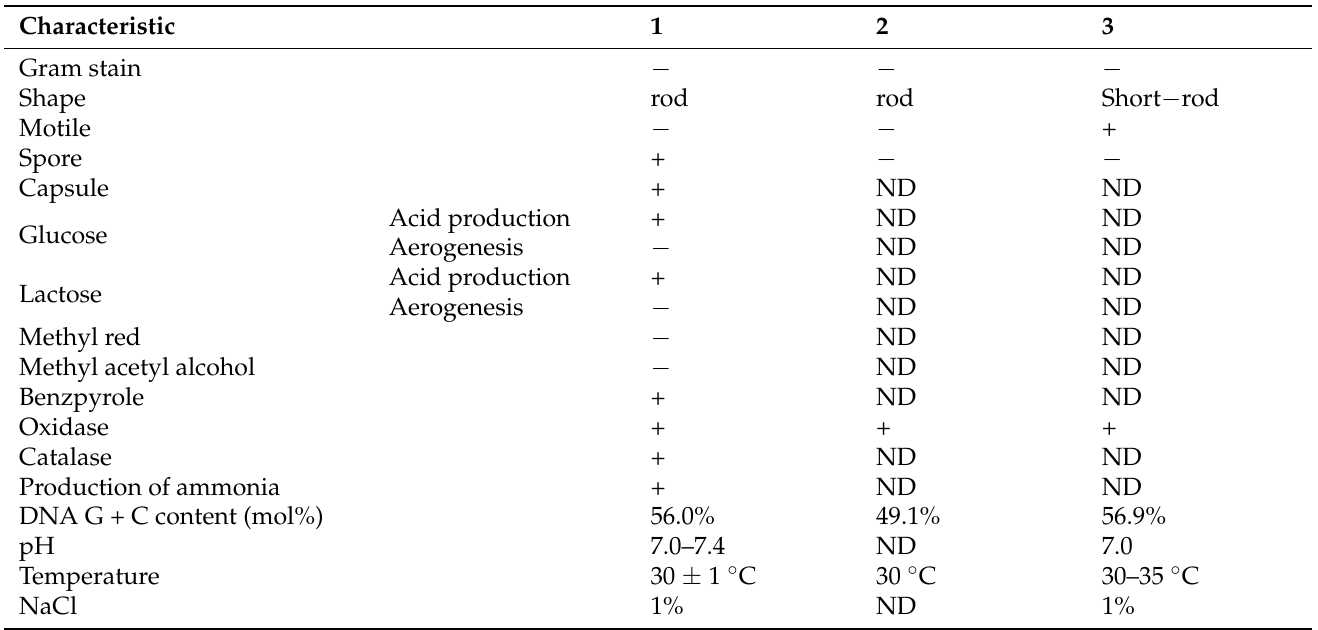
Table 3. Physiological characteristics of strain TDYN1 and the species of the genus Falsochrobactrum . Strains: 1, TDYN1; 2, Falsochrobactrum ovis B1315 T [28]; 3, Falsochrobactrum shanghaiense HN4 T [27]; +, positive; − , negative, ND, no data. The results of TDYN1 were from this study, other data were from the